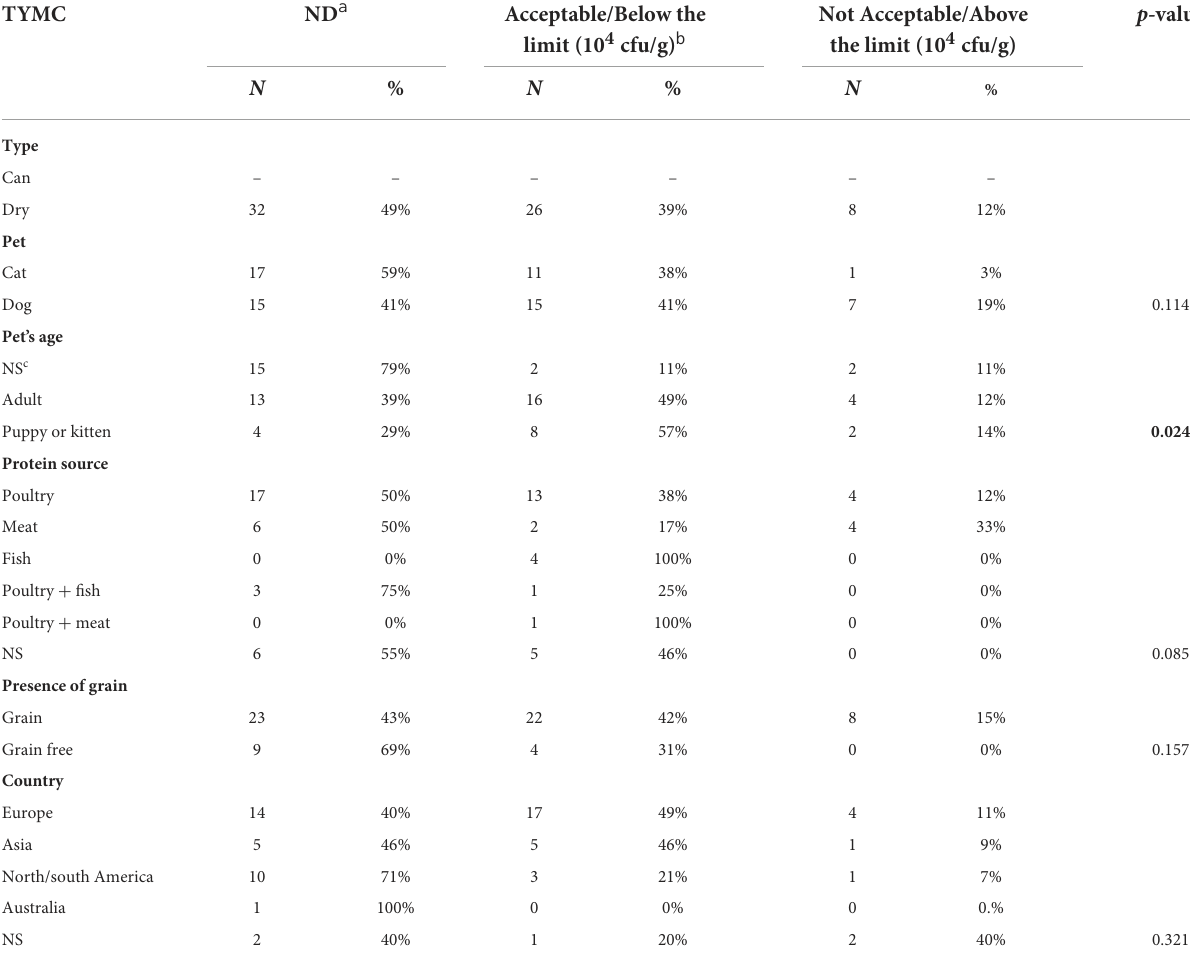
TABLE 6 Microbiological results of total yeasts and molds count in dry pet food. TYMC ND